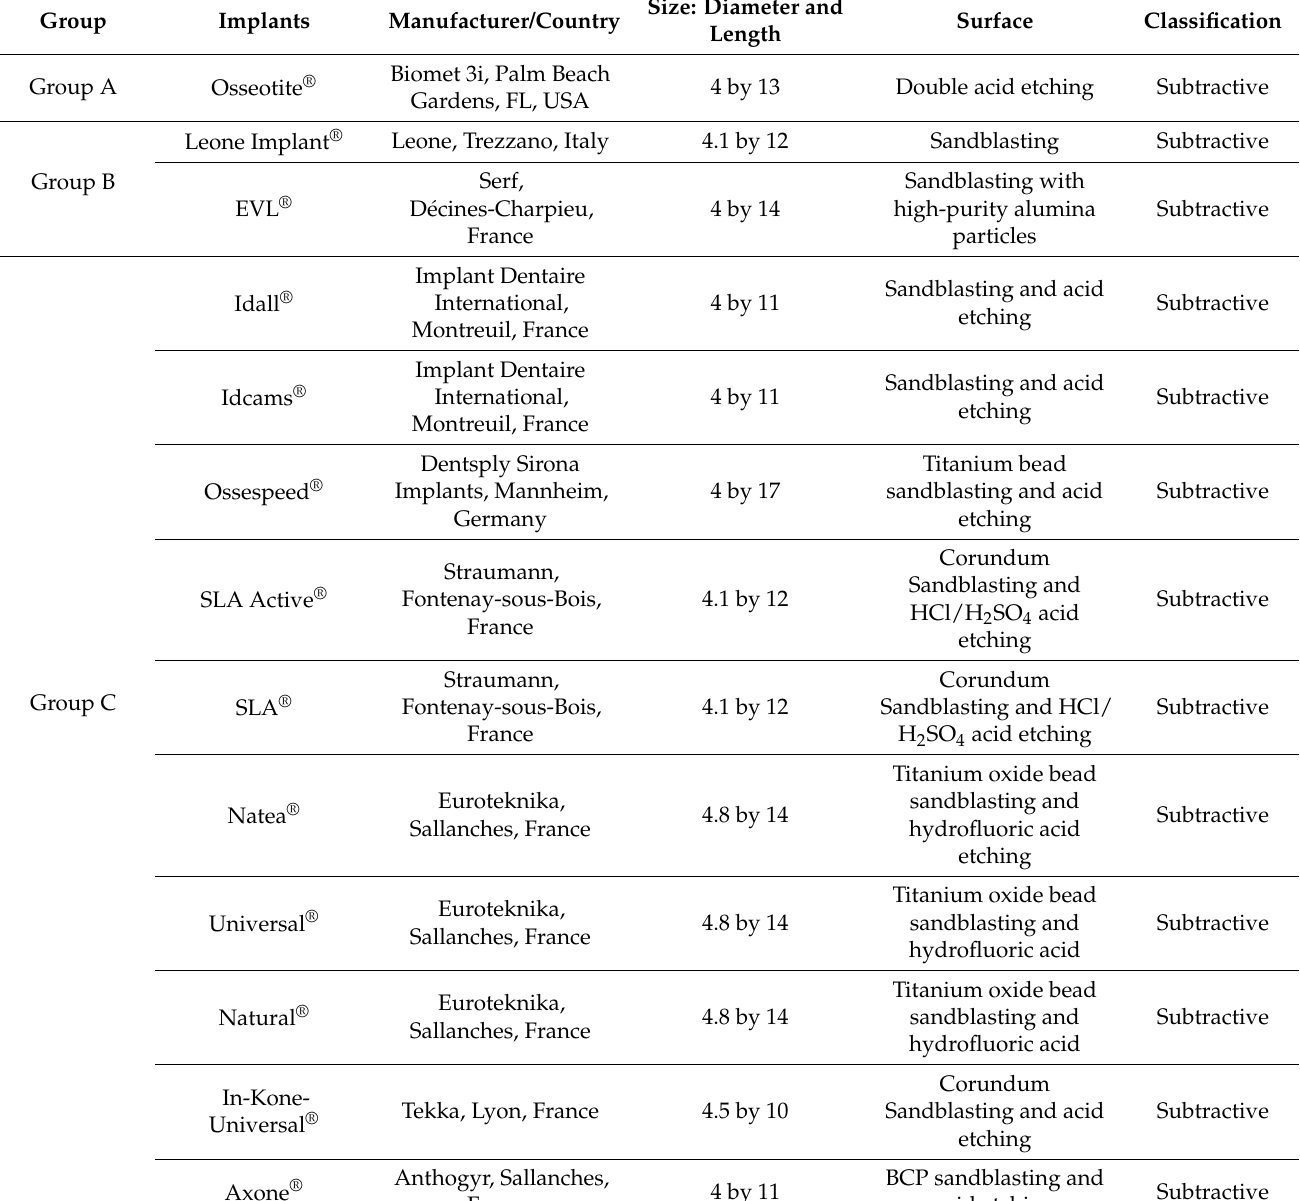
Table 1. Names, manufacturers, dimensions, manufacturing processes, and classifications of all 13 implants